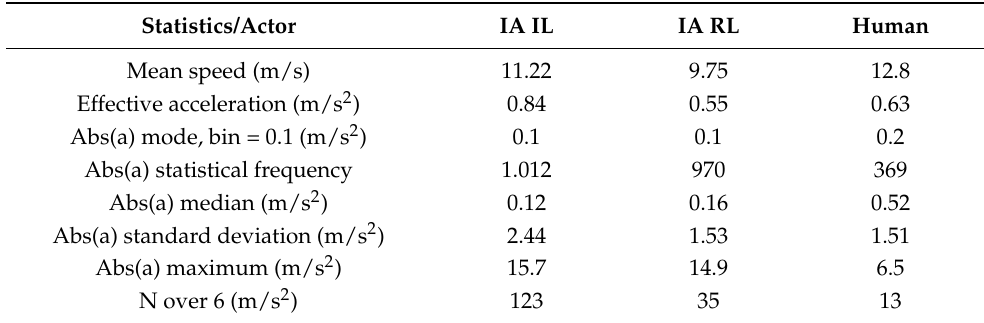
Table 10. Case 1. Mean speed and statistics derived from acceleration of IAs and human expert on the training track.